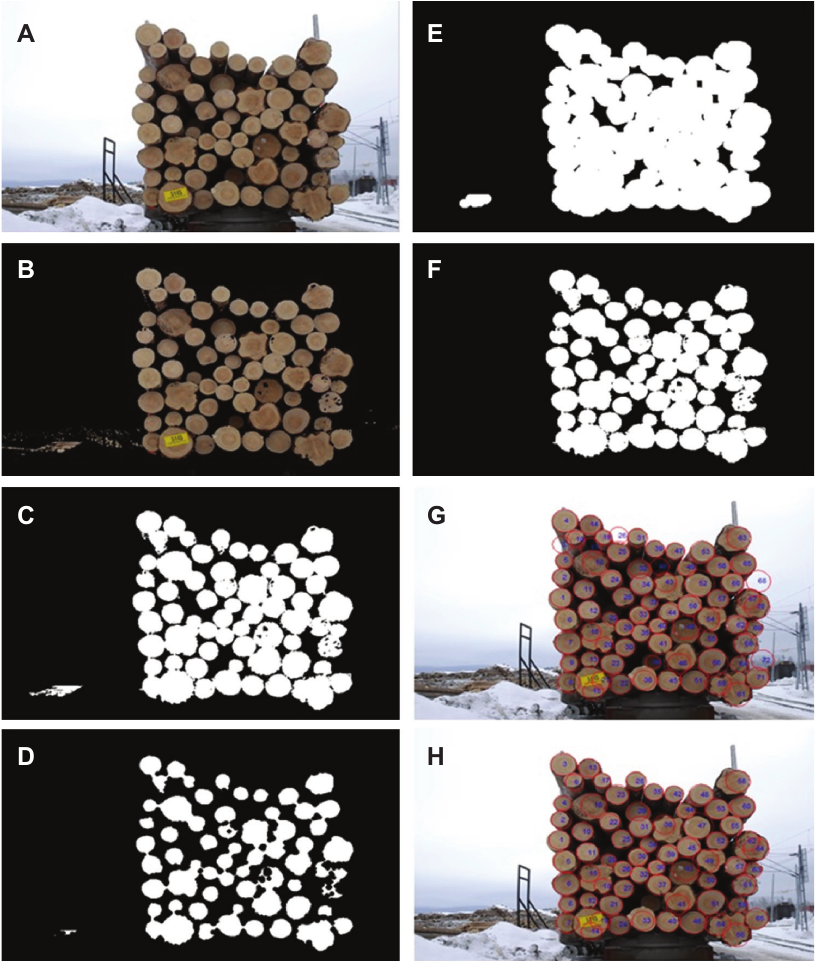
Figure 2. Various Stages of Processing Aimed at Detecting and Counting the Logs. Notice that the Log Detection Accuracy is >